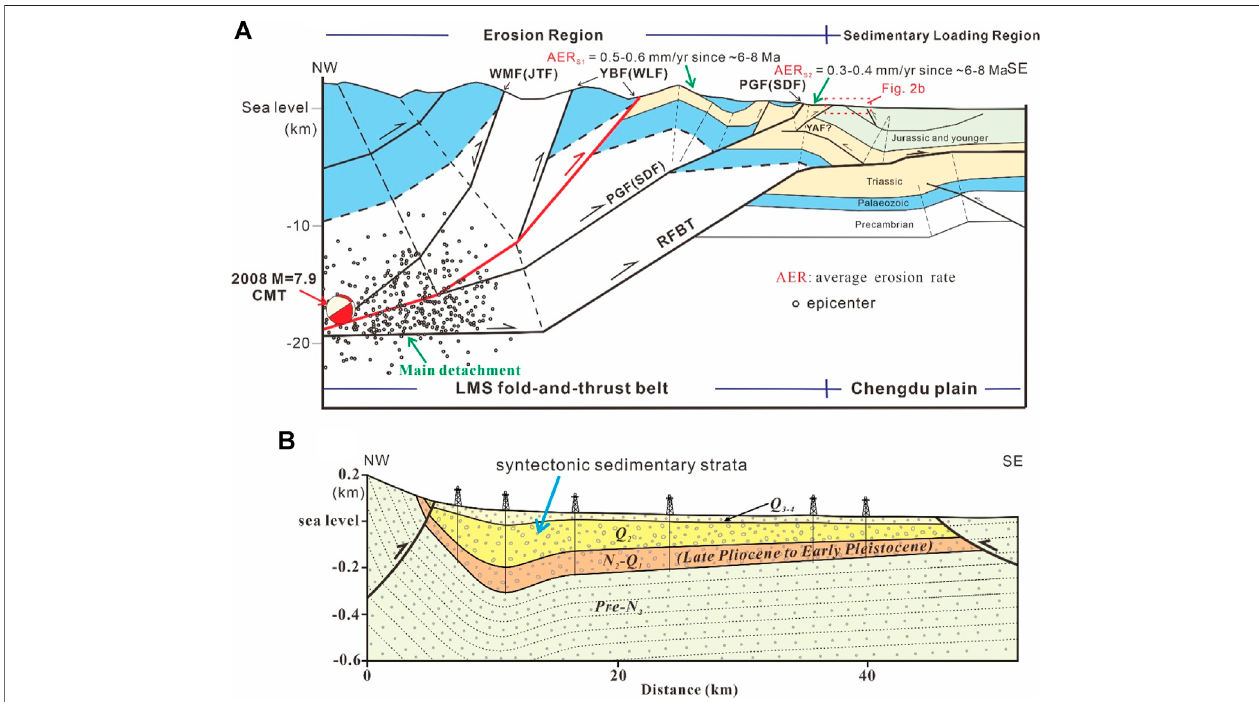
FIGURE 2 | (A) the geologic cross-section of the southern LMS fold-thrust belt (modi fi ed from Hubbard and Shaw, 2009, see the location in Figure 1 ; data of average erosion rate (AER) reference from Ye, 2021; epicenter data from Li et al., 2010); (B) a geological pro fi le shows the synkinematic sedimentation deposited in the southern LMS active fold-thrust belt (Li Z. et al., 2018). The pro fi les show that there are typical characteristics of synkinematic erosion and sedimentary loading in the southern LMS fold-thrust belt.